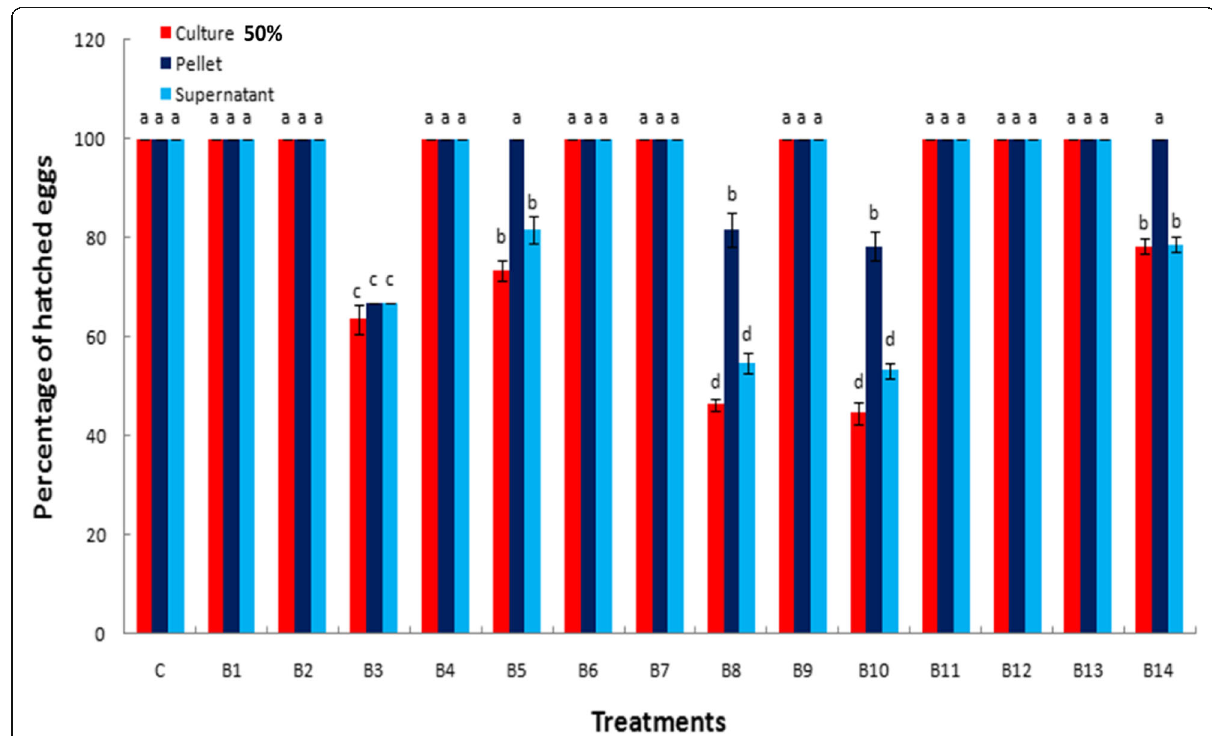
Fig. 1 Effect of culture broth, cell pellet, and supernatant of 14 Bacillus subtilis isolates (B1 to B14, C is a control) on egg hatching of Meloidogyne incognita at a concentration of 50%. Values with the identical letters above the bar are not significantly different at P < 0.05